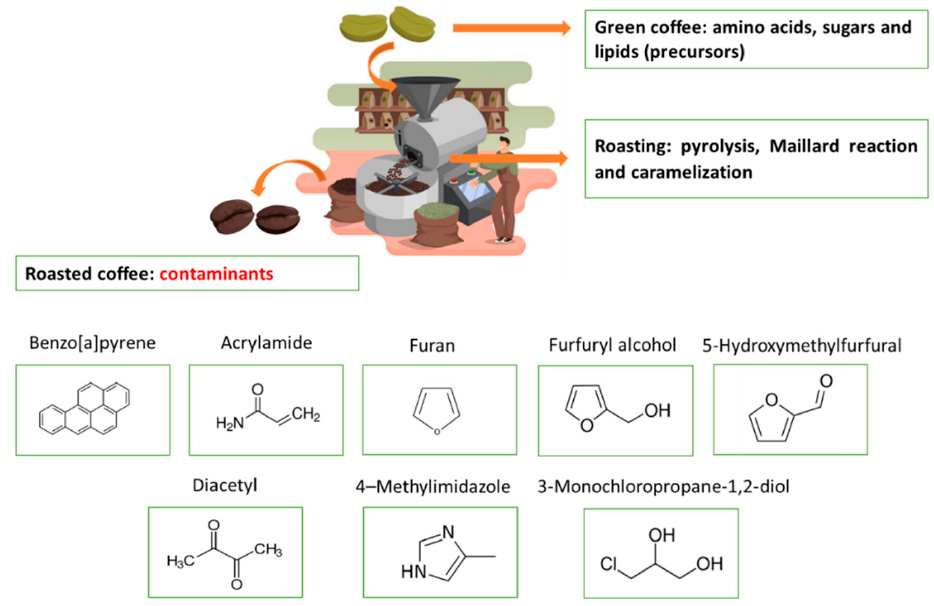
Figure 5. Thermal contaminants in co ff ee induced by roasting (authorial).